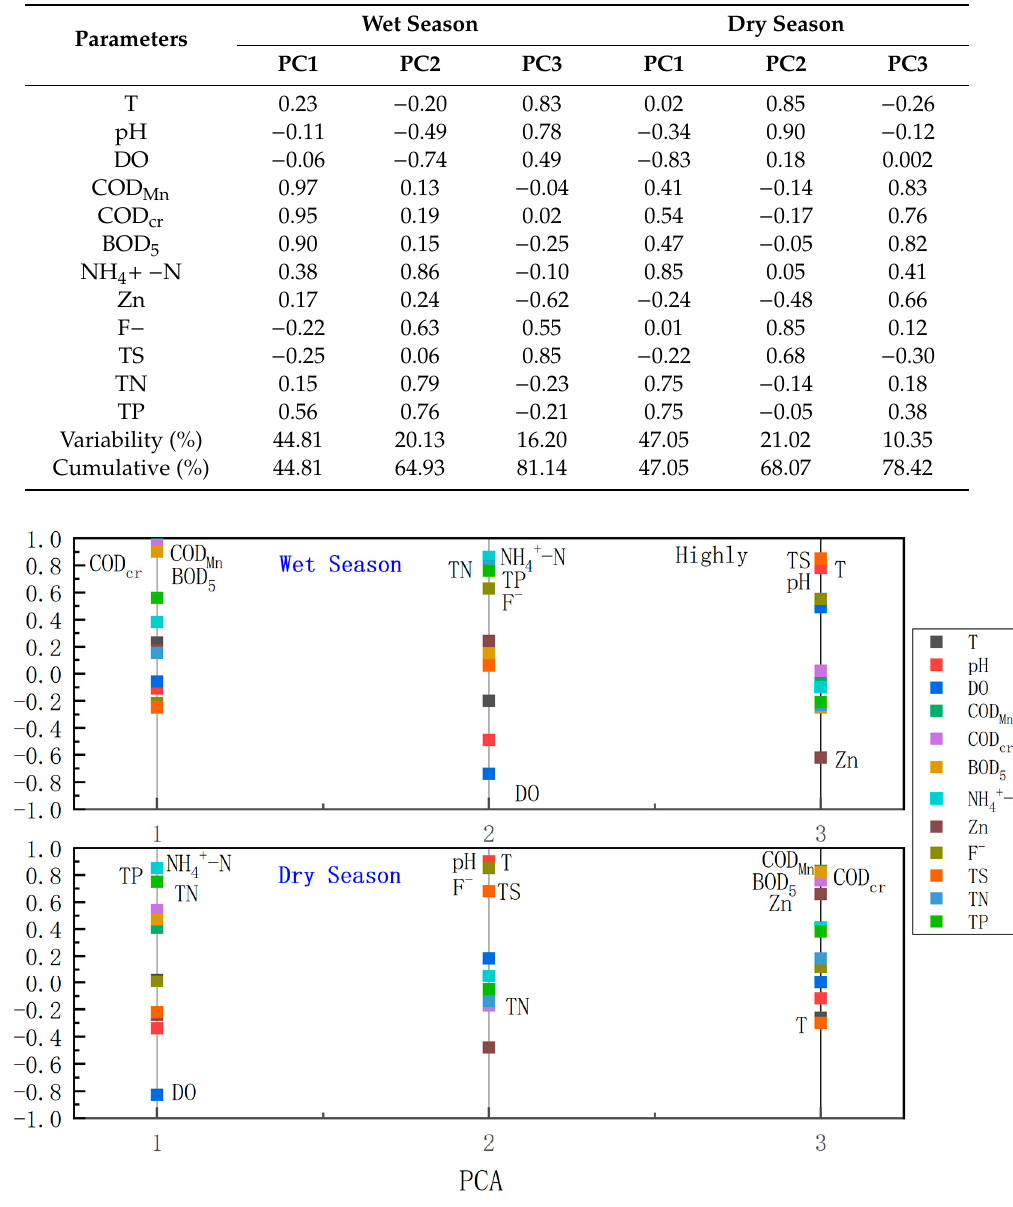
Figure 2. Variable loadings on varimax rotated factors of principal component analysis (PCA) in wet (top) and dry (bottom) seasons in the Qinhuai River, East China.